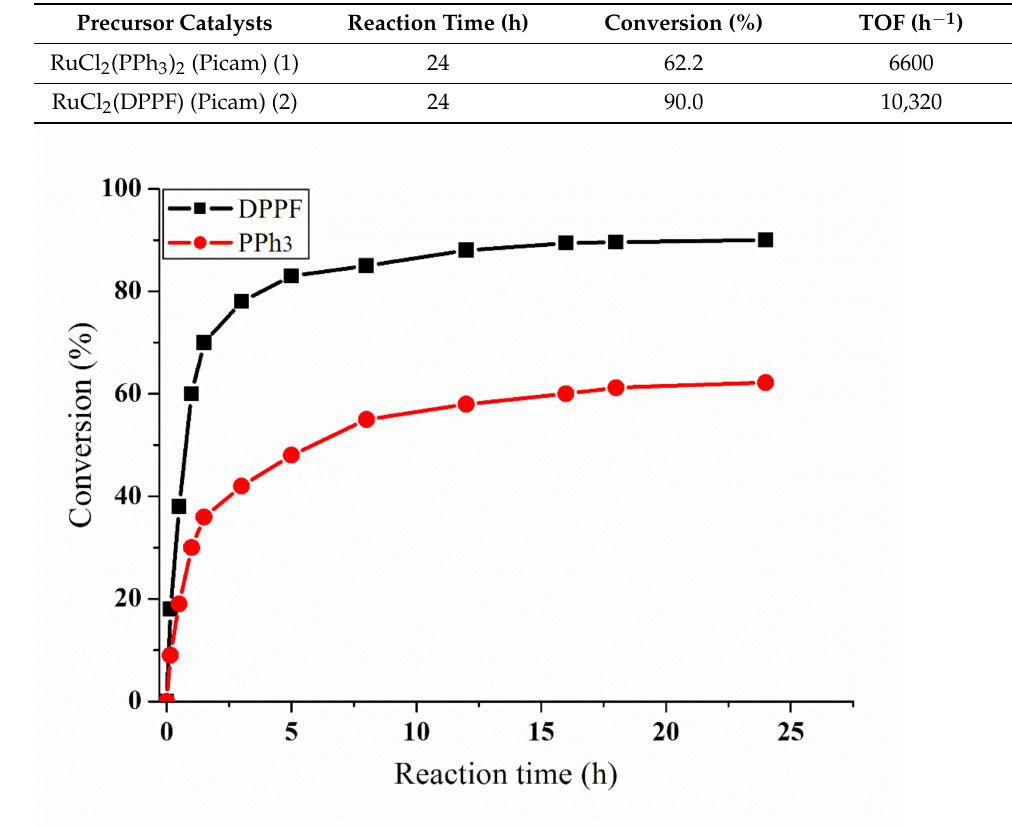
Figure 3. Catalytic hydrogen transfer reaction. Table 1. Catalyzed transfer hydrogenation reduction of acetophenone.